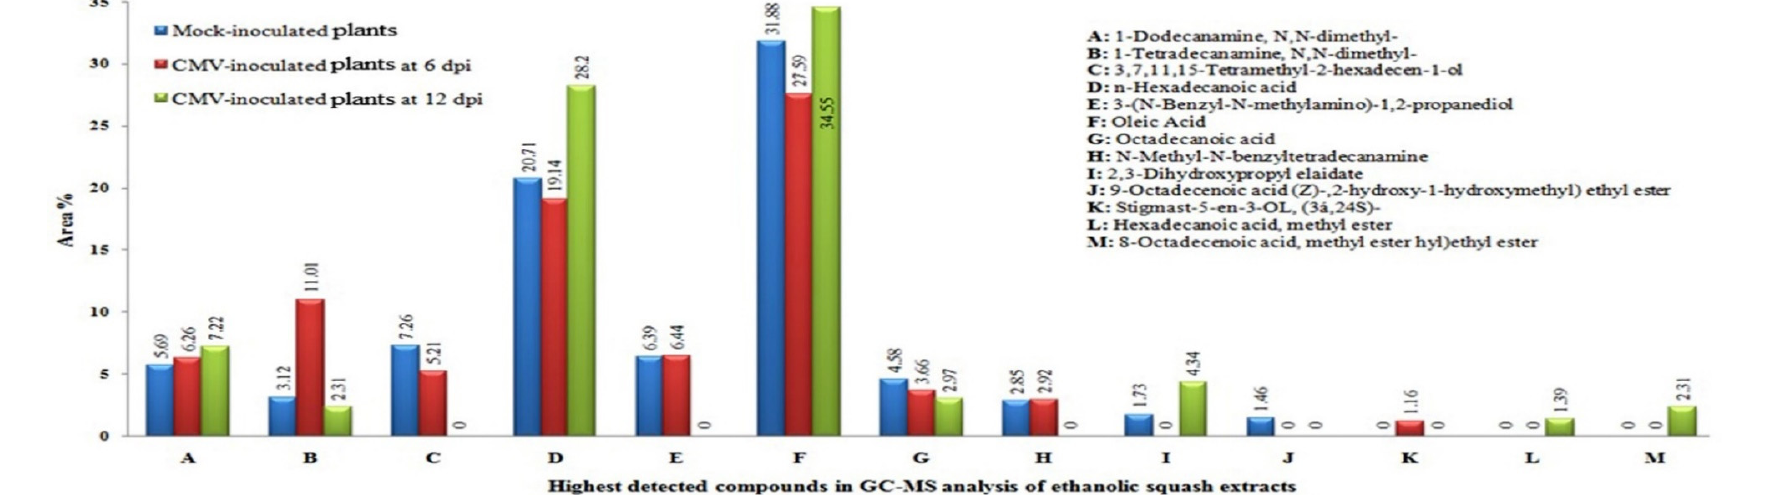
Figure 8. GC–MS chromatograms of ethanolic extract of squash plants. Mock-inoculated plants (A), CMV-inoculated plants at 6 dpi (B), and 12 dpi (C).